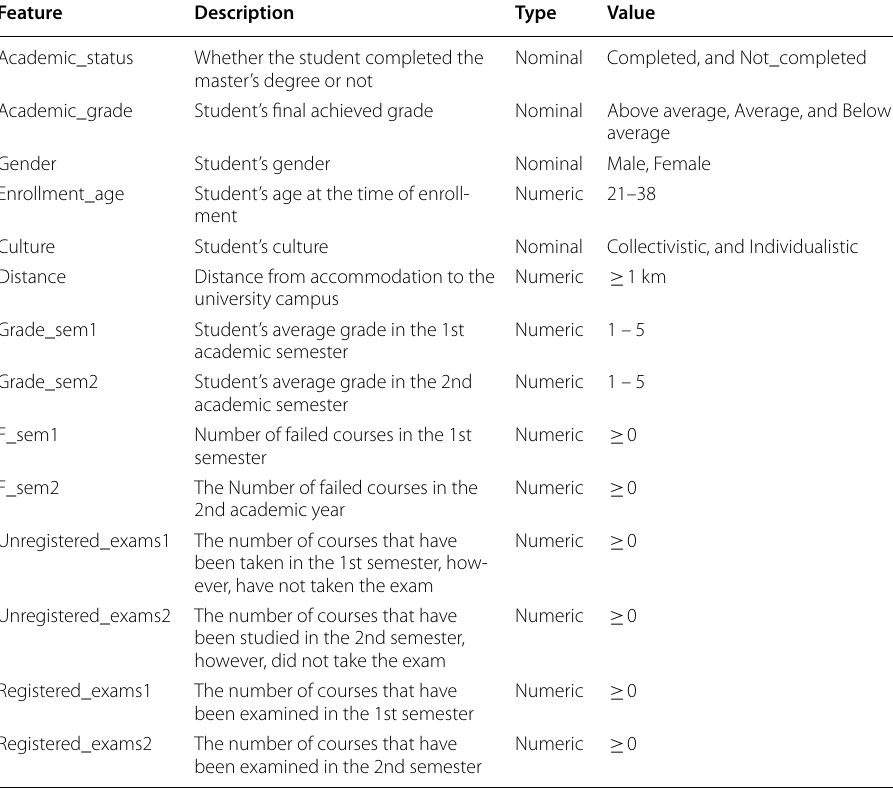
Table 2 Description of the collected data that is used to predict the academic